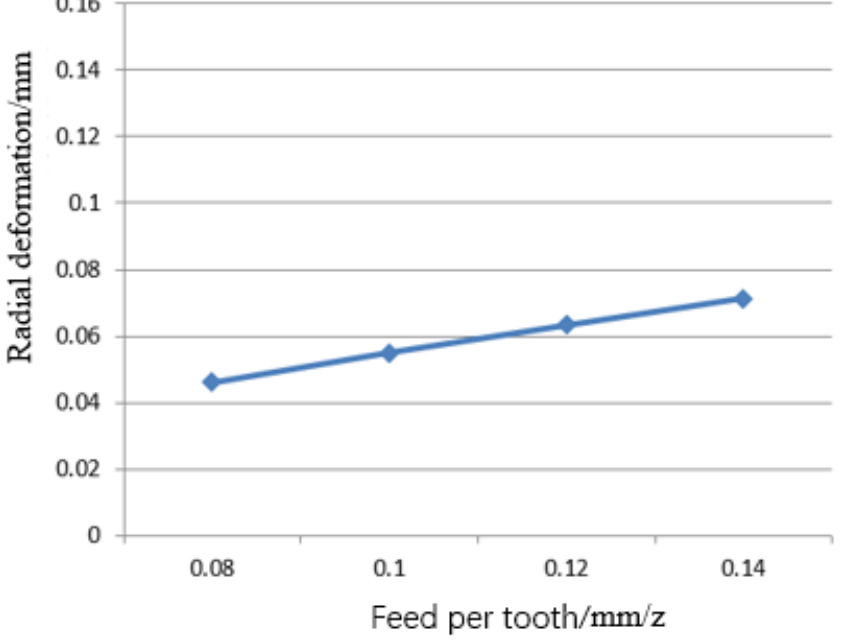
Figure 11. Influence of feed per tooth on machining deformation.